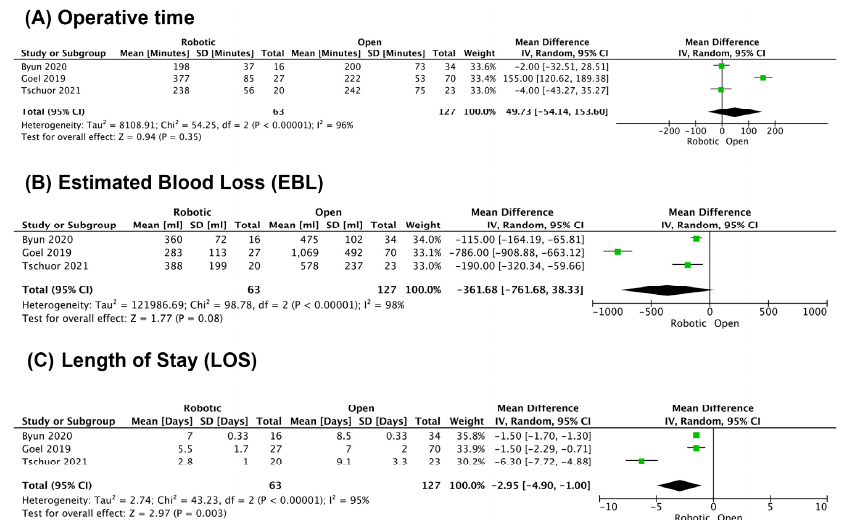
Figure 2. Meta-analysis of robotic vs. open surgery for radical cholecystectomy. ( A ) Operative time in minutes; ( B ) Estimated Blood Loss in ml; ( C ) Length of hospital stay in days. The critical appraisal of all included studies was performed with the Joanna Briggs Institute checklist. Most case series did not have clear inclusion criteria, and few reported consecutive inclusions, resulting in an increased risk of selection bias (Figure 3A). With regards to case reports, three out of four studies did not have clear description of potential adverse events (Figure 3B). Furthermore, the quality of the four comparative studies in- cluded in Table 3 were also evaluated with the Newcastle-Ottawa Scale, and each scored 7 out of 9. The major limitation of these studies was the lack of adjustment for potential confounders.